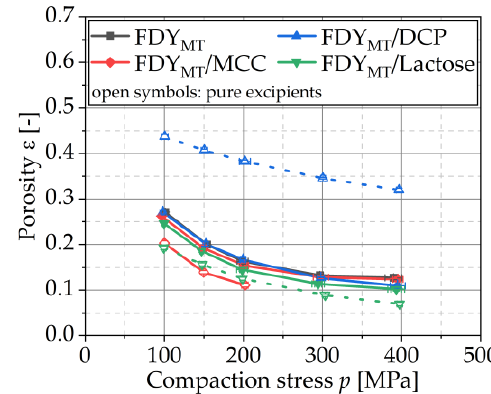
Figure 7. Compressibility profiles of FDY MT and FDY MT mixed with MCC, DCP and lactose as well as of pure excipients. Symbols represent means and error bars standard deviation; n = 10. Pharmaceutics 2020 , 12 , x FOR PEER REVIEW